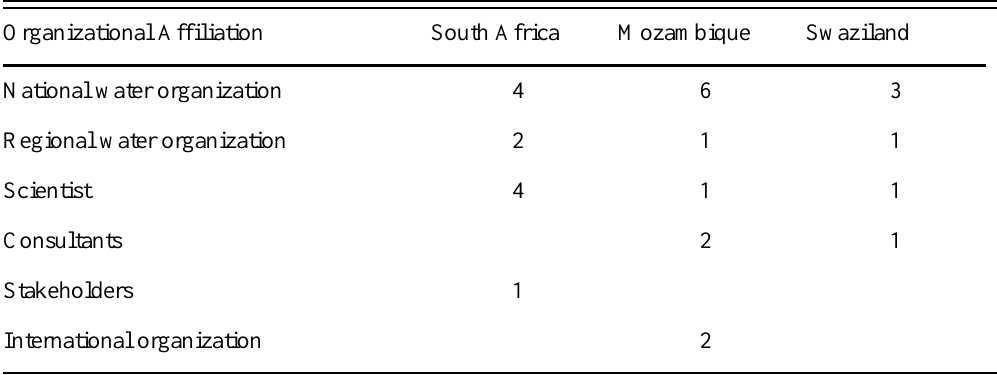
Table 2. Categorization of respondents according to organizational affiliation and